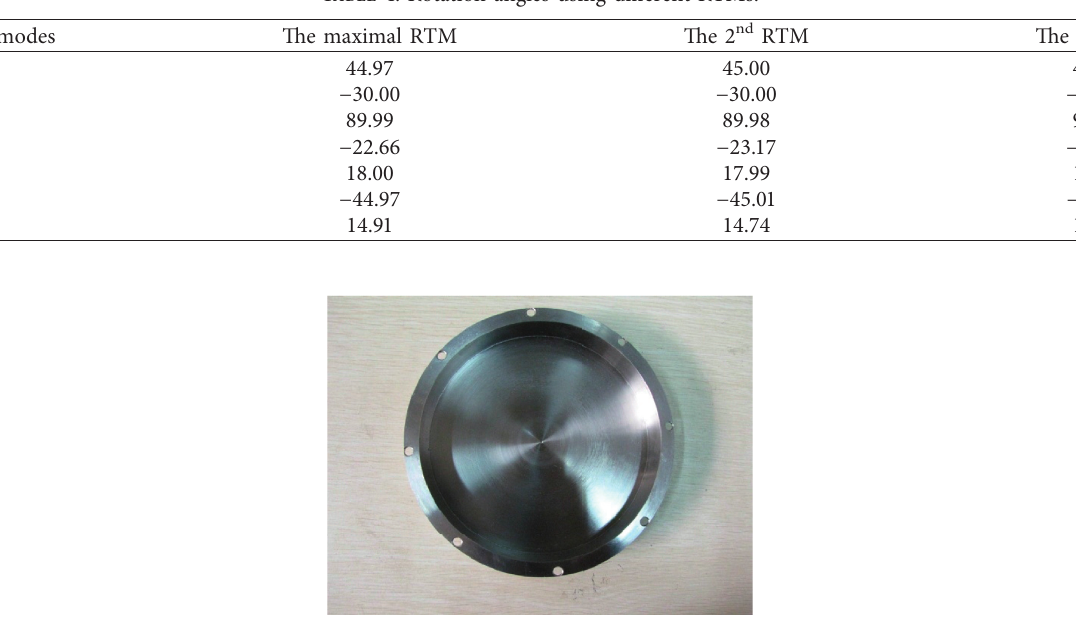
Table 4: Rotation angles using different RTMs.